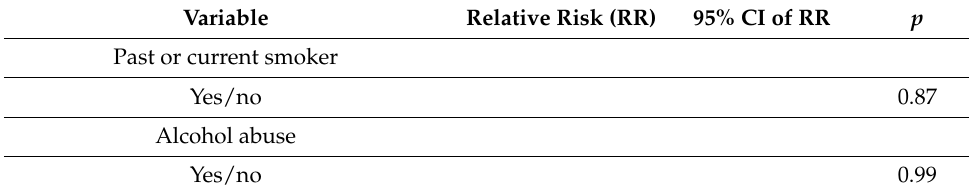
Table 3. Cont. Variable Relative Risk (RR) 95% CI of RR p Past or current smoker Yes/no 0.87 Alcohol abuse Yes/no